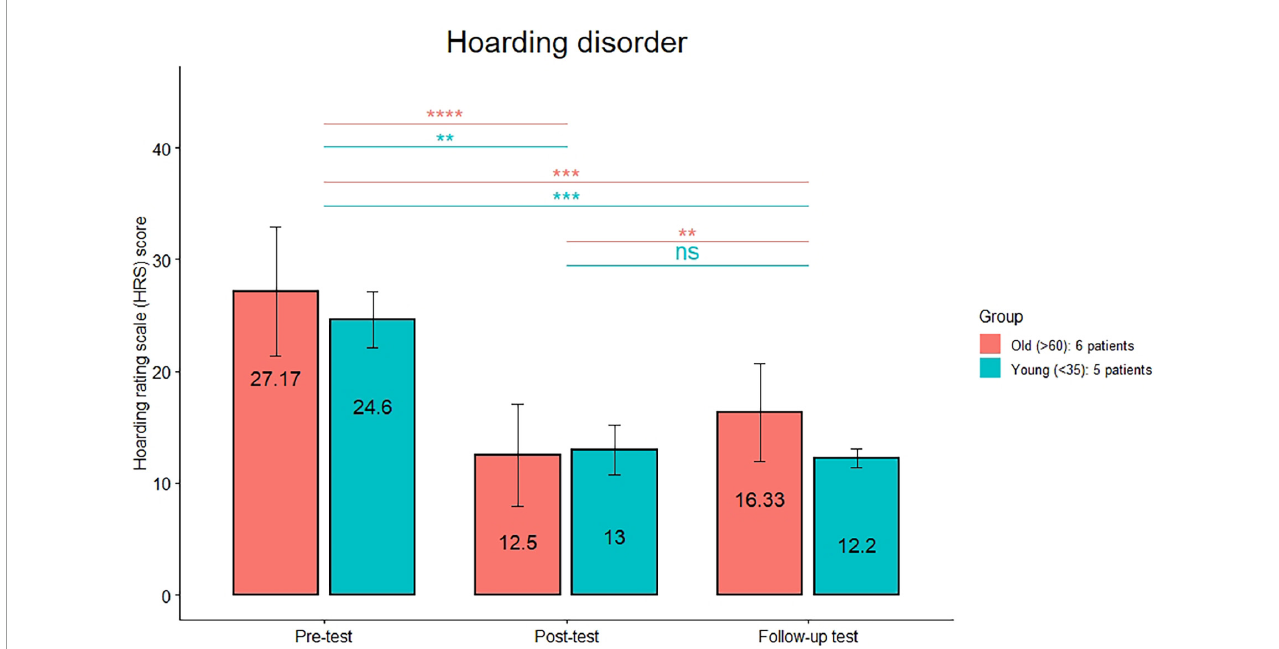
FIGURE1 Hoarding Rating Scale mean scores are reported for the young and old subgroups in the hoarding group at the three timepoints (pre-treatment, post-treatment, and 1 month follow-up). **** p < 0.0001; *** p < 0.001; ** p < 0.01; n.s.: not significant.